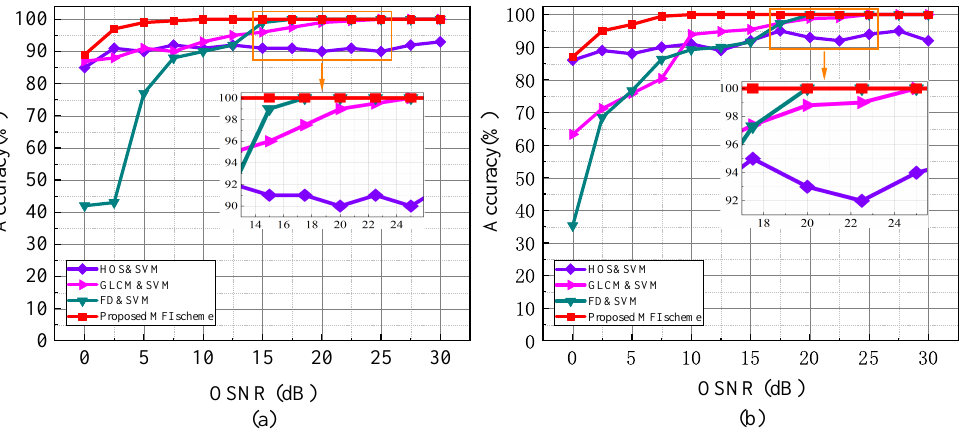
Figure 8. Comparison of the overall identification accuracy of the seven signals with different MFI schemes. The fiber distance is set as ( a ) 80 km, ( b ) 120 km.